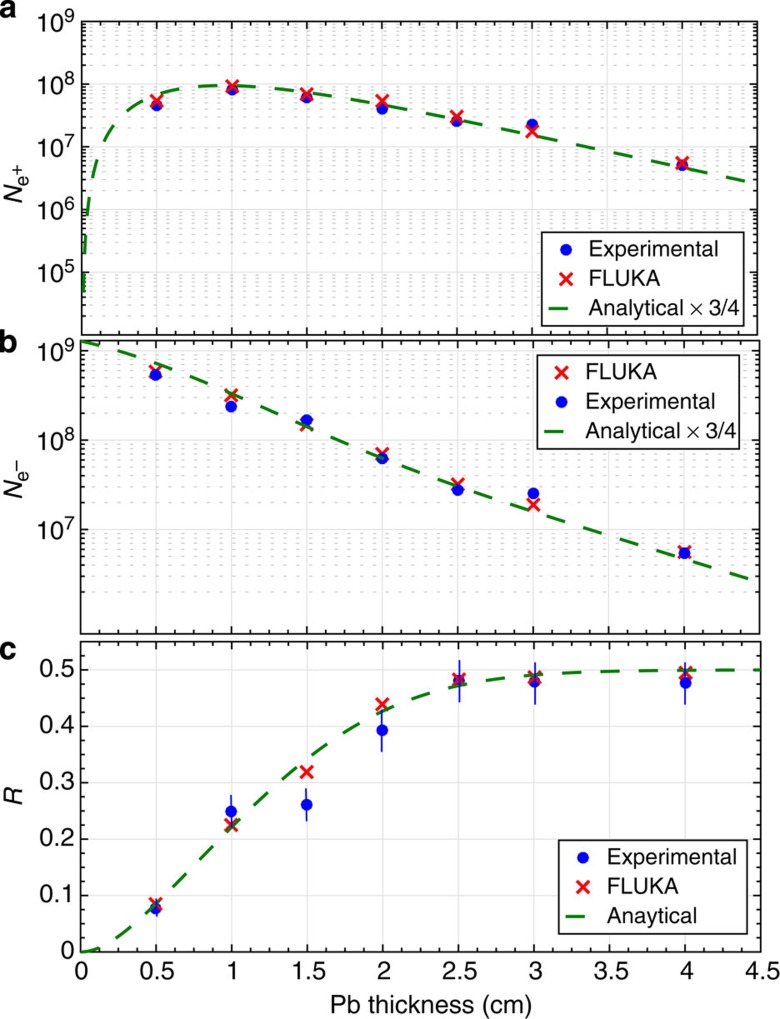
Percentage of positrons in the leptonic beam.(a) Measured (blue circles) and simulated (red crosses) number of positrons as a function of the Pb thickness (, see main text). The green dashed line represents the analytical prediction (discussed in the text). (b) Measured (blue circles) and simulated (red crosses) number of electrons as a function of the Pb thickness (, see main text). The green dashed line represents the analytical prediction (discussed in the text). For these two frames, error bars lie within the size of the circles. (c) Percentage of positrons in the leptonic jet: measured (full blue circles), simulated (red crosses) and analytical prediction (green dashed lines). For all panels, the error bars mainly arise from shot-to-shot fluctuations. FLUKA simulations indicate that the overall number of relativistic electrons and positrons (Ee≥1 MeV) behave in a similar manner. The percentage of positrons in the beam reaches ∼50% for d>2.5 cm≈5Lrad.